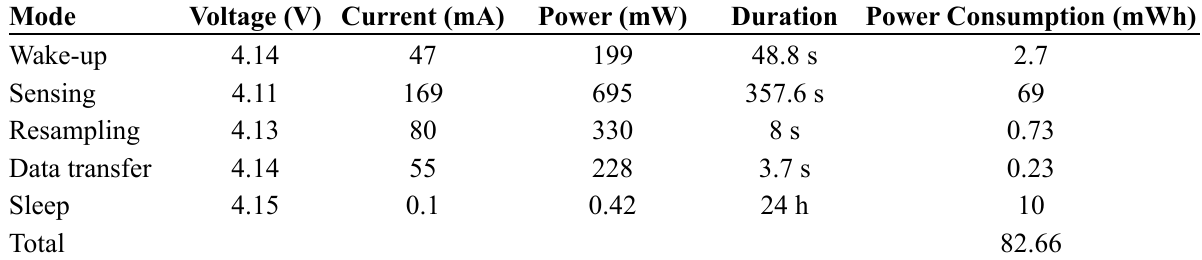
Table 3. Estimated daily power consumption of